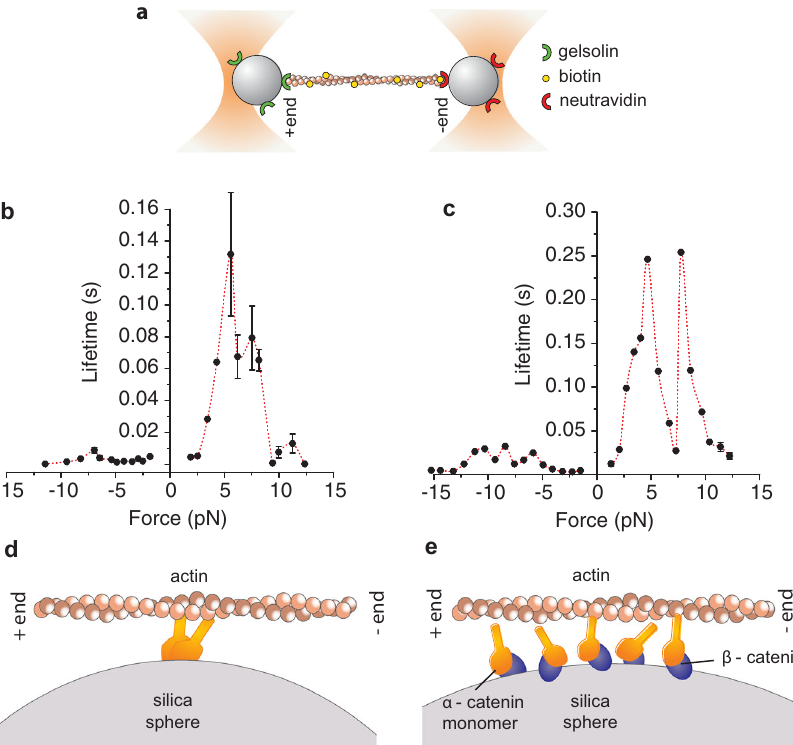
Fig. 4 α -catenin resists load directed toward the F-actin pointed end. a Schematic of the oriented actin fi lament experiments. b Load-dependent lifetime of the interaction between a single α -catenin homodimer and F-actin. Average from 3 dumbbells. n = 9891 total number of interactions for all points in the plot. Error bars, s.e.m. c Load-dependent lifetime of the interaction between multiple α - β -catenin heterodimers and F-actin. Average from 3 dumbbells. n = 79790 total number of interactions for all points in the plot. Error bars, s.e.m. Error bars are smaller than symbols. Source data are provided as a Source Data fi le. d , e Schematic of the single α -catenin homodimer ( d ) and multiple α - β -catenin heterodimers ( e ) interacting with an oriented actin fi